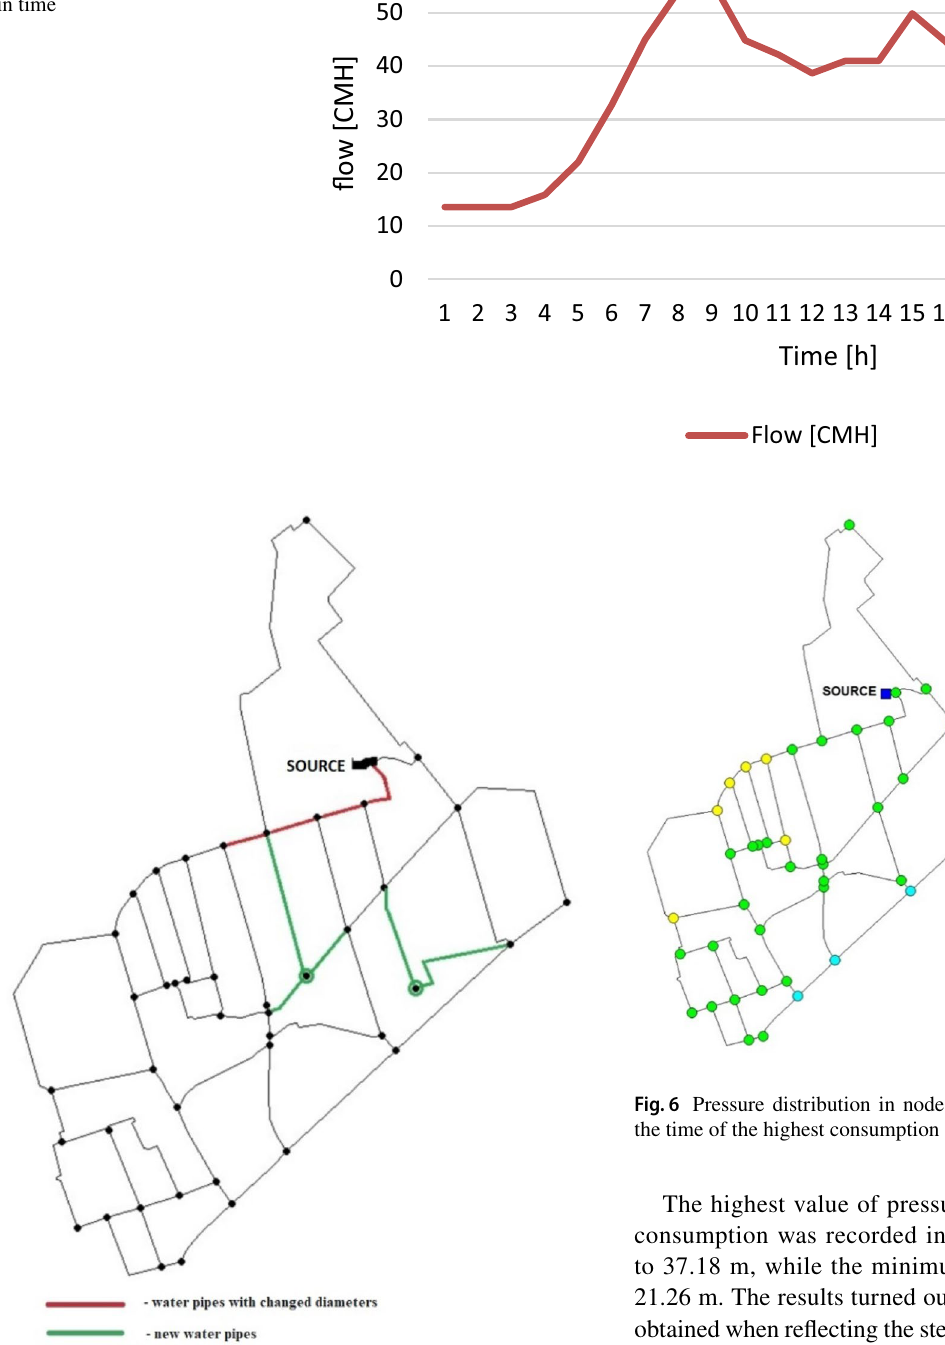
Fig. 4 Graph of the course of water consumption in the model in time